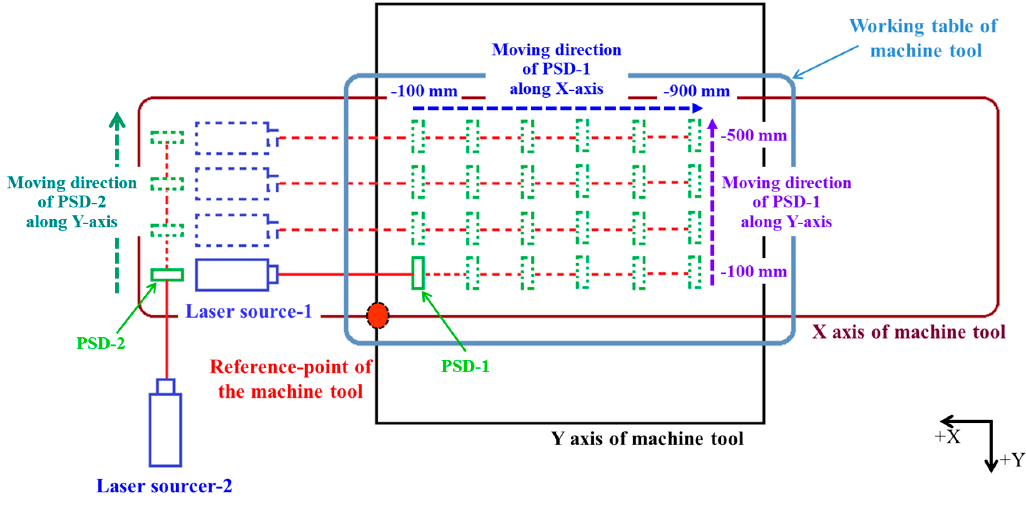
Figure 7. Schematic diagram of dual-axis measuring mechanism.